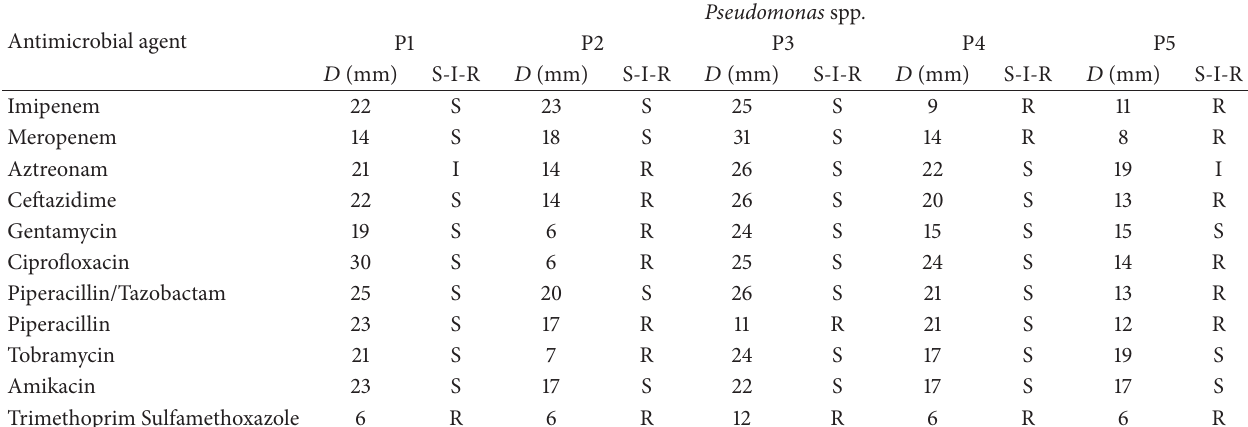
Table 2: Antibiotic Susceptibility Testing for Pseudomonas spp.